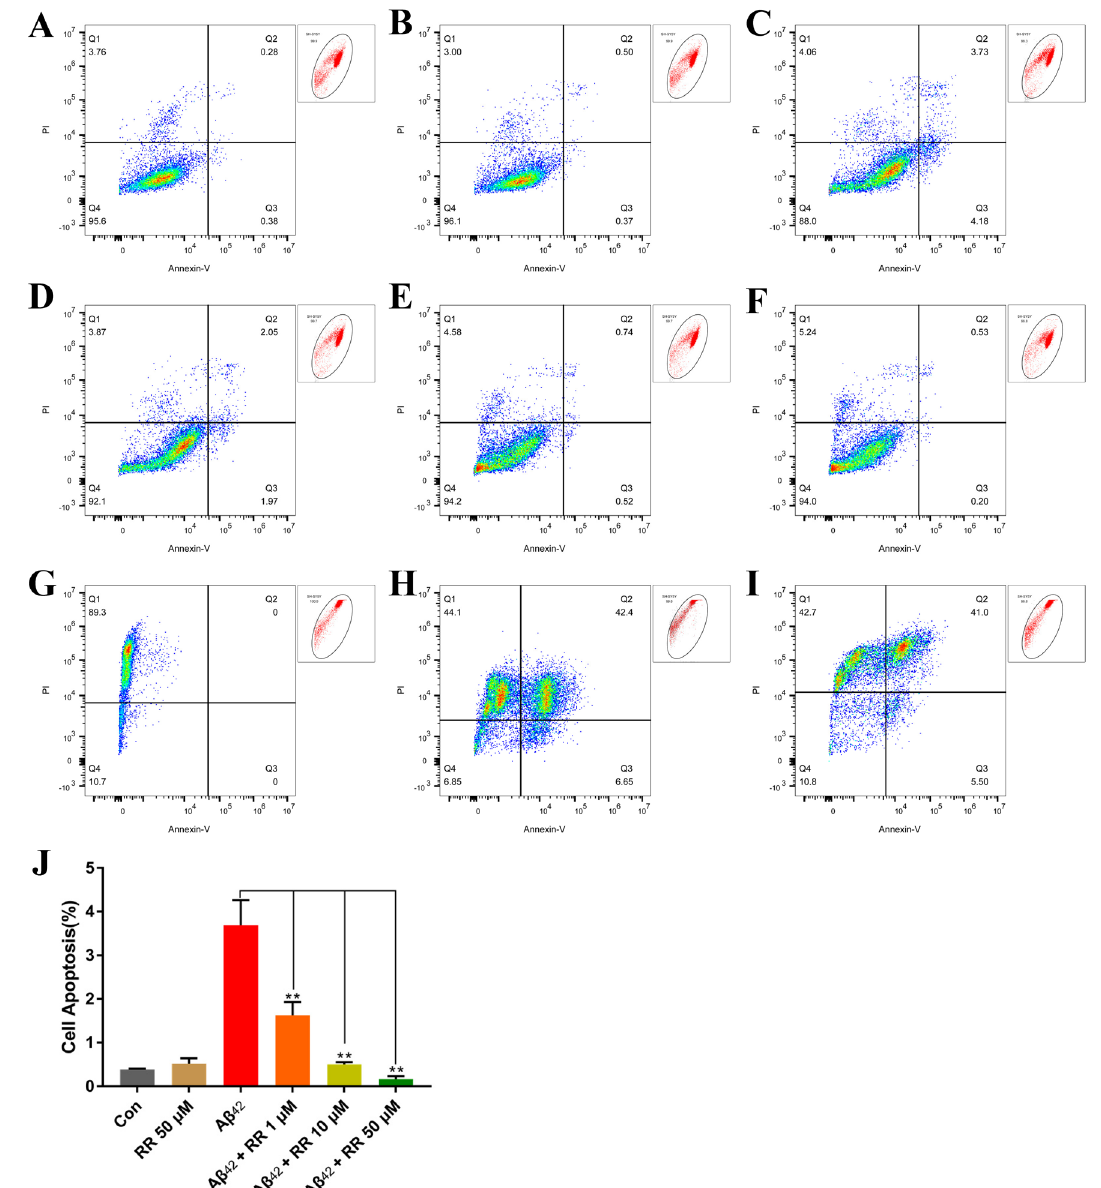
Figure 11. Flow cytometry analysis of the effects of arginine dipeptide on cell apoptosis. ( A ) Apoptosis in A β 42 -nonsecreting SH-SY5Y cells treated with control medium (Con). ( B ) Apoptosis in A β 42 -nonsecreting SH-SY5Y cells treated with arginine dipeptide (RR) at 50 µ M. ( C ) Apoptosis in SH-SY5Y cells secreting A β 42 . ( D – F ) Apoptosis in A β 42 -secreting SH-SY5Y cells treated with RR at 1, 10 and 50 µ M of A β 42 , respectively. ( G – I ) SH-SY5Y cells incubated with PI, Alexa Fluor 488 annexin V conjugate, and both of them, respectively. ( J ) Quantification of cell apoptosis with FlowJo TM . Results are expressed as mean ± SEM. ** p < 0.01, analyzed by one-way ANOVA, followed by the Tukey’s post-hoc test for multiple comparison, n =